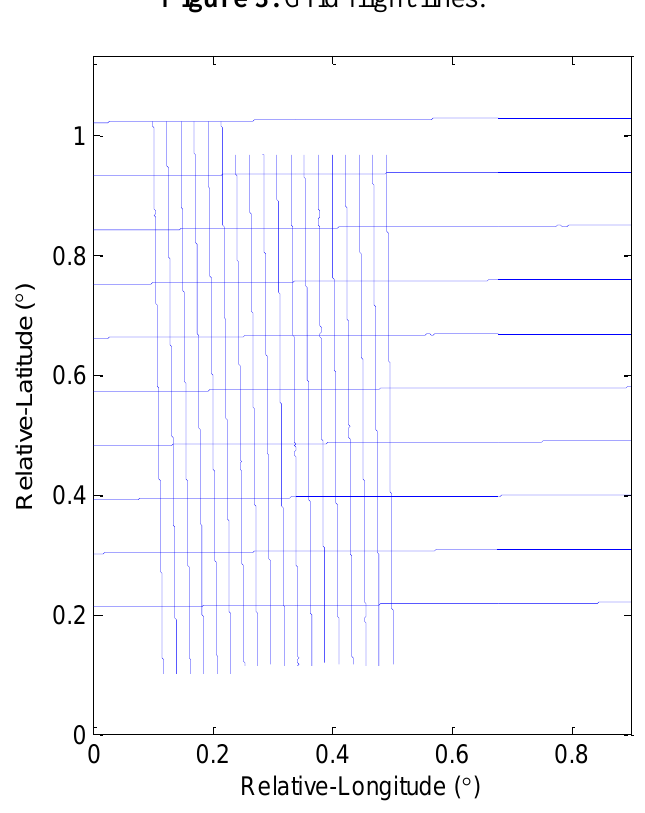
Figure 3. Grid flight